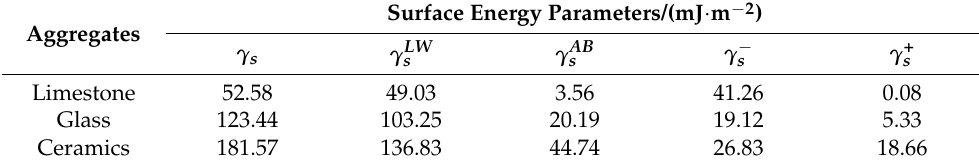
Table 8. Aggregate surface energy parameters.